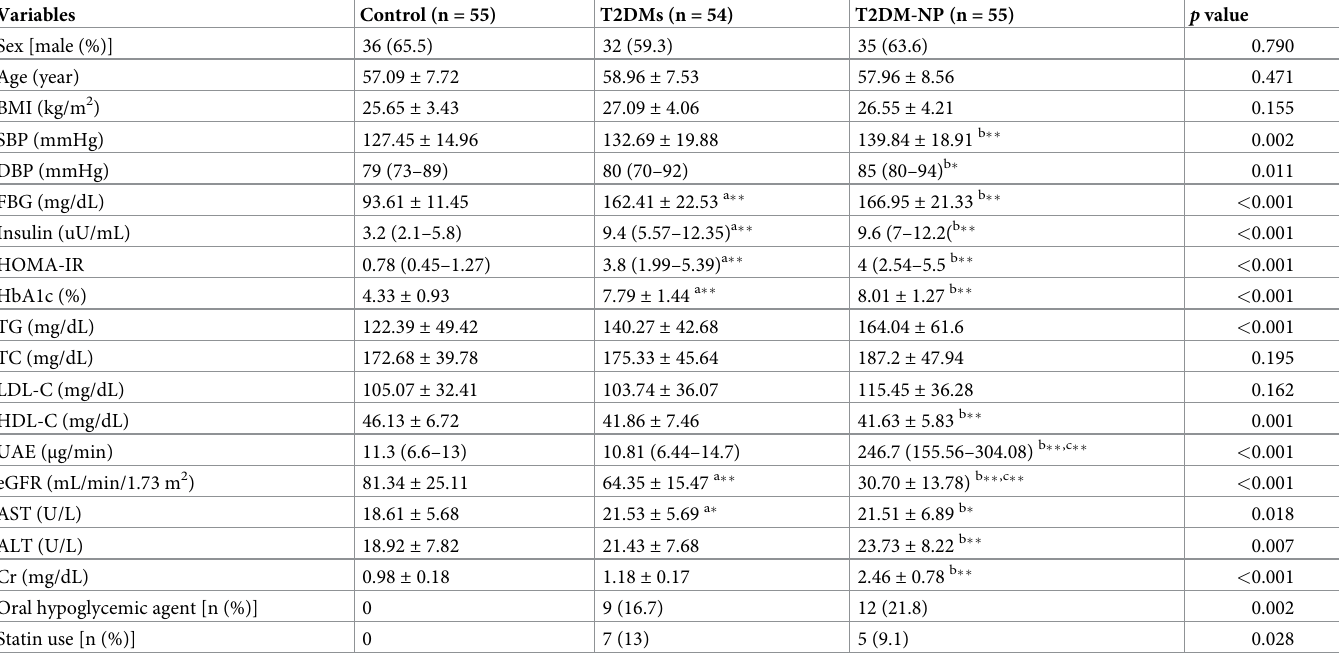
Table 1. Anthropometric and biochemical characteristics of study